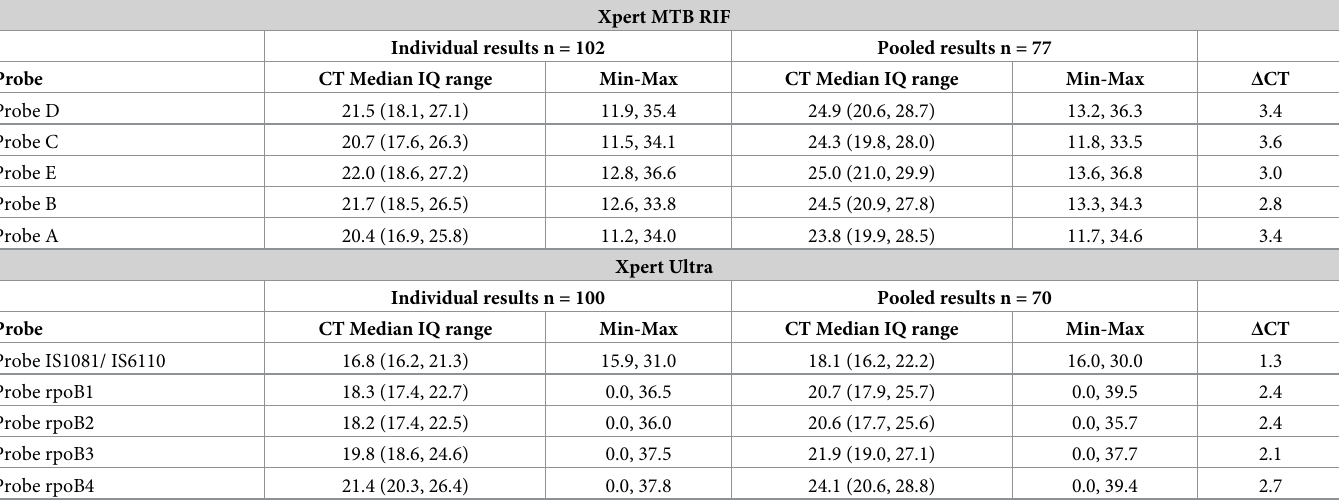
Table 3. Median CT values of individual and pooled Xpert MTB/RIF and Xpert Ultra probe